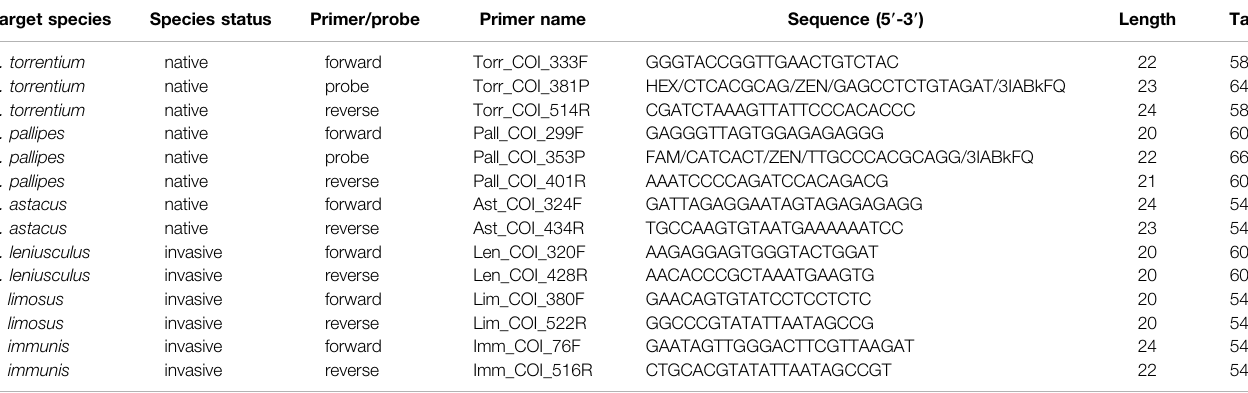
TABLE 1| Speci fi cprimerpairsforallcray fi shspeciesinvestigatedinthisstudyand ddPCR probesfor A.torrentium and A.pallipes (speciesnameandstatus,primer/probe name, primer sequence, length in basepairs, annealing temperature (Ta) used in the PCR